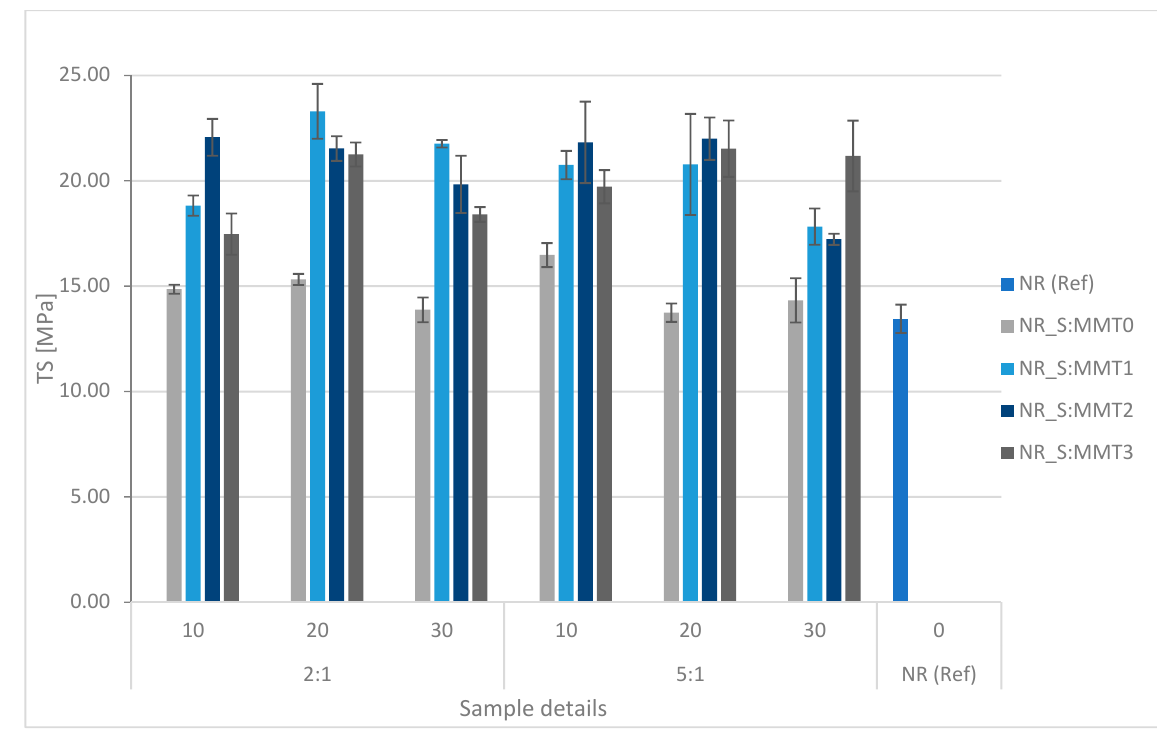
Figure 13. Influence of the type of biofiller and its content on the tensile strength values of vulcanizates.